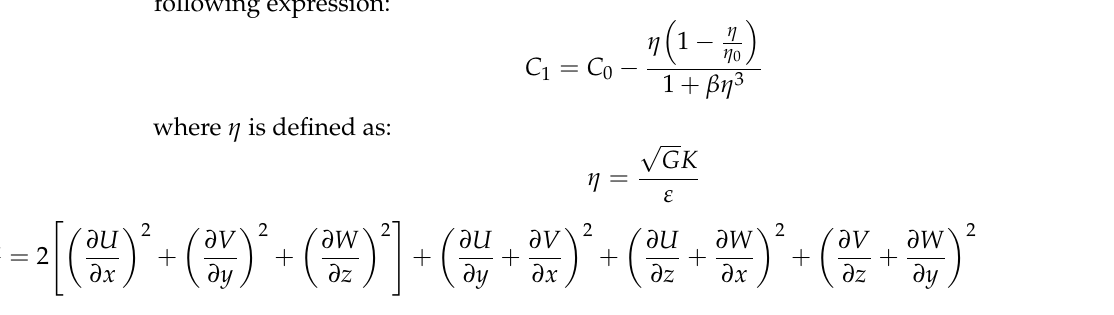
Table 1. RNG model constants used in the